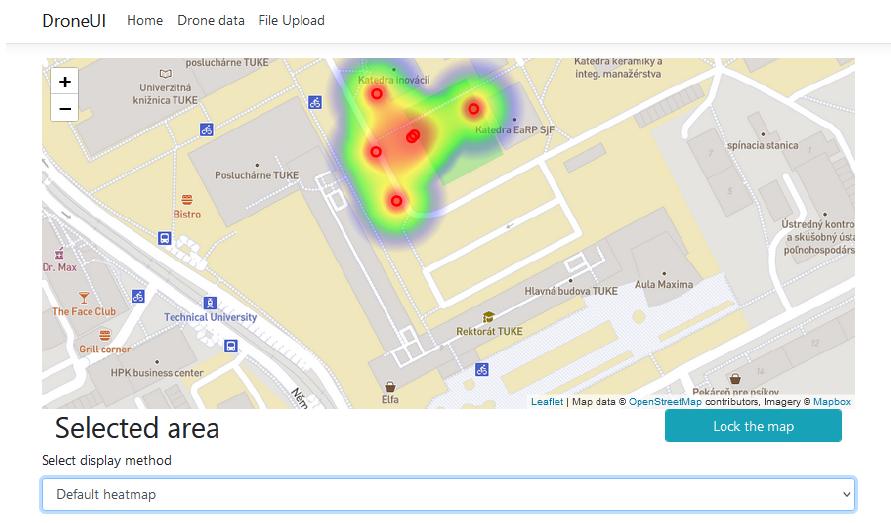
Figure 5. Data points displayed using a